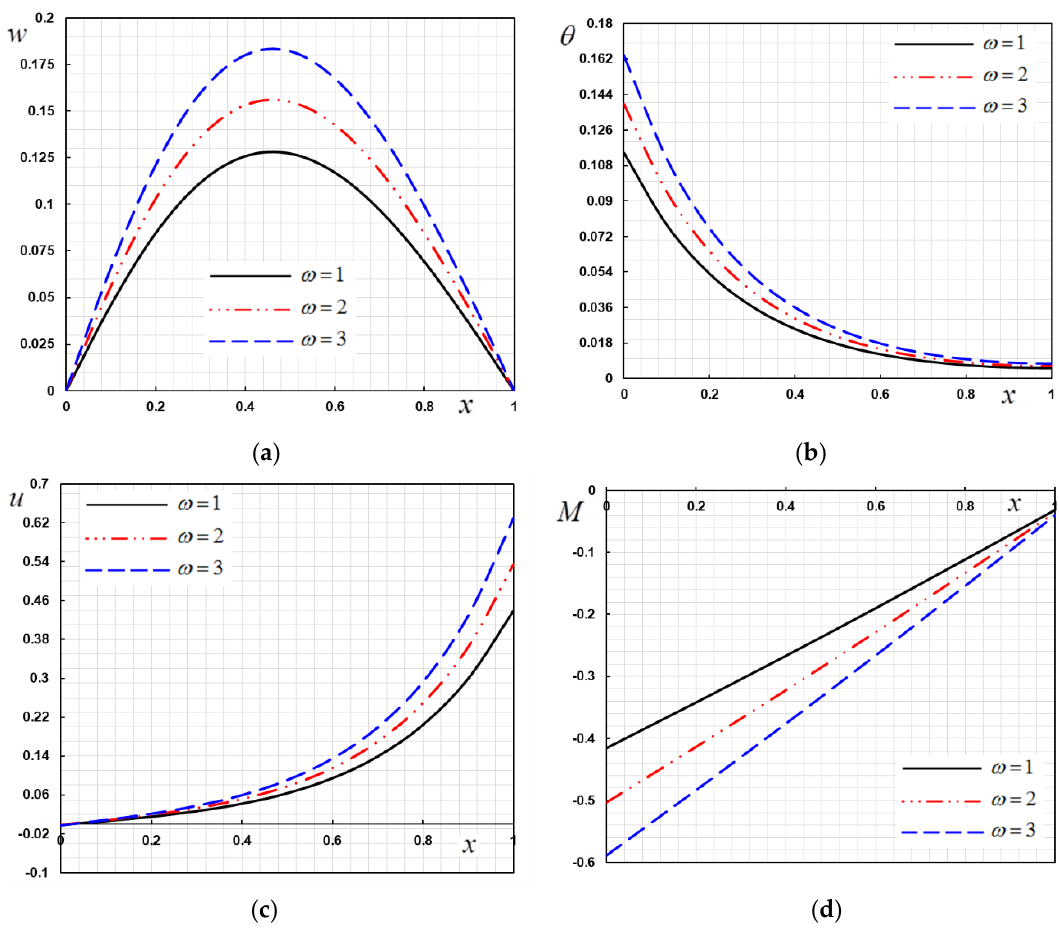
Figure 5. ( a ) The deflection w for di ff erent thermal vibration frequencies ω . ( b ) The temperature θ for di ff erent thermal vibration frequencies ω . ( c ) The displacement u for di ff erent thermal vibration frequencies ω . ( d ) The bending moment M for di ff erent thermal vibration frequencies ω